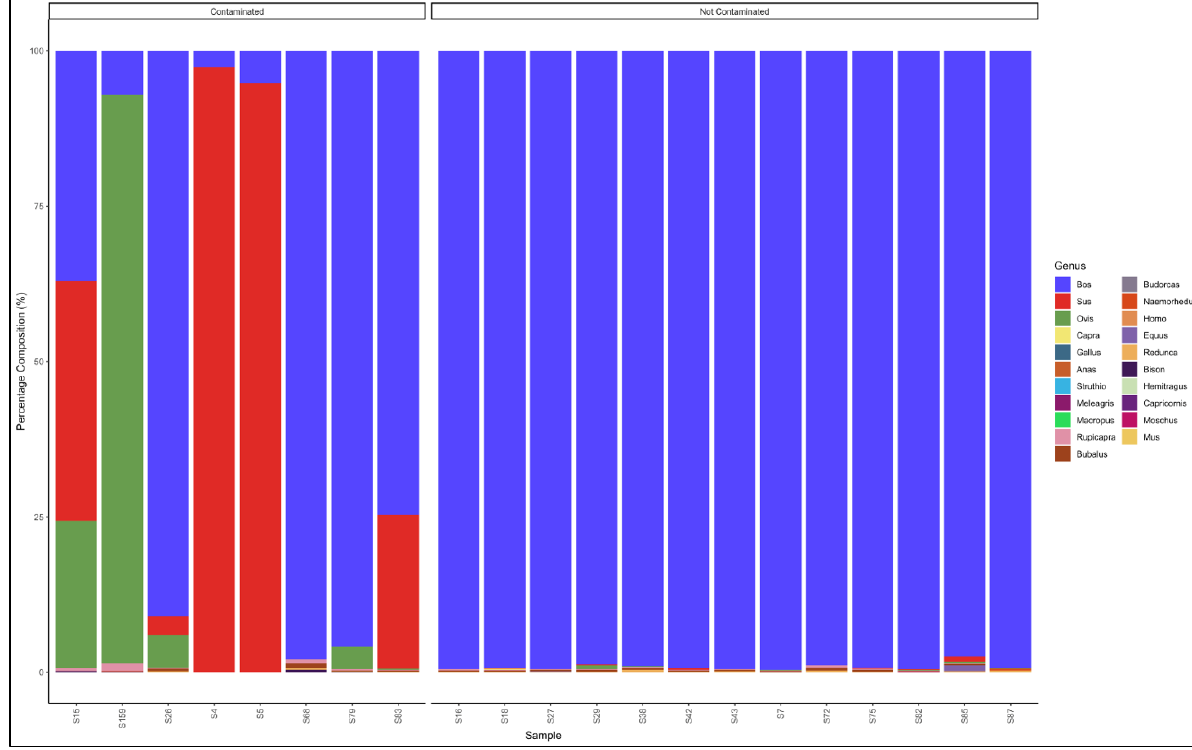
Figure 10 . Percentage composition for sausage samples not specified which species they are from.